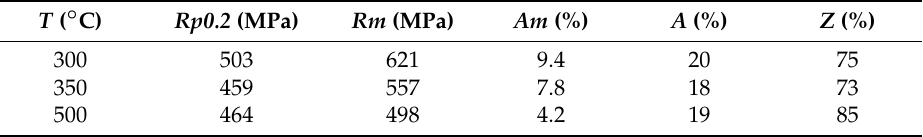
Figure 1. Light Microscope image of the microstructure of the T91 steel in the as-received state